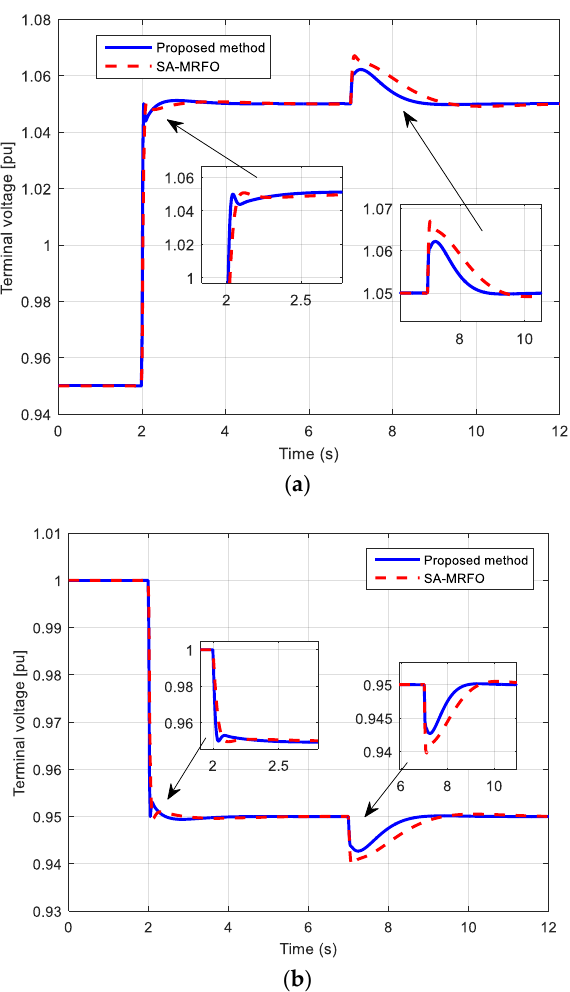
Figure 10. Generator voltage response for: ( a ) step change of the reference voltage from 0.95 to 1.05 p.u and excitation step change +0.5 p.u, ( b ) step change of the reference voltage from 1 to 0.95 p.u and excitation step change −0.3 p.u. Table 6. Comparison of the transient response provided using the regulator parameters given in Table 5.